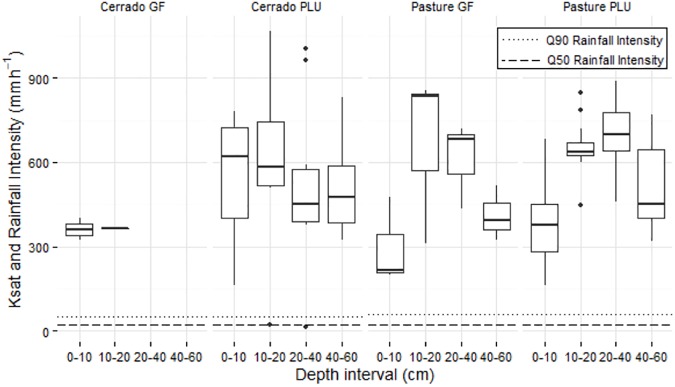
Boxplot of the Ksat results, and the 50th and 90th percentiles of the rainfall intensity in the cerrado and pasture catchments.